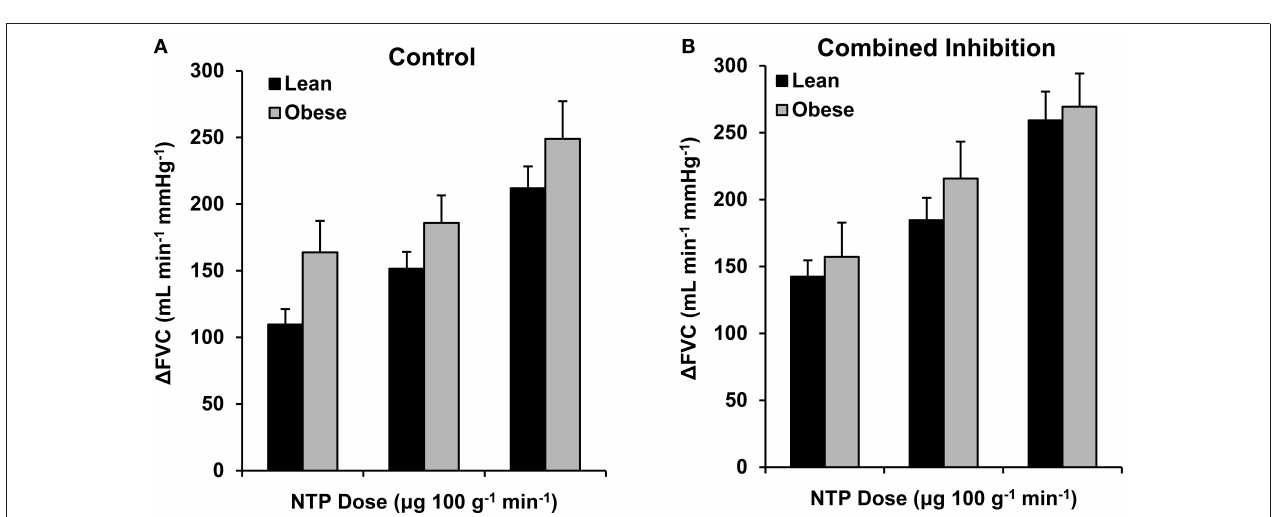
FIGURE 5 | NTP responses with combined inhibition. Change in forearm vascular conductance ( (cid:2) FVC) with intra-arterial NTP infusion. (A) (cid:2) FVC without inhibition was not different between obese ( n = 26 ) and lean ( n = 44 ) adults. (B) (cid:2) FVC with combined NOS-COX inhibition was not different between obese adults ( n = 19 ) and lean adults ( n = 36